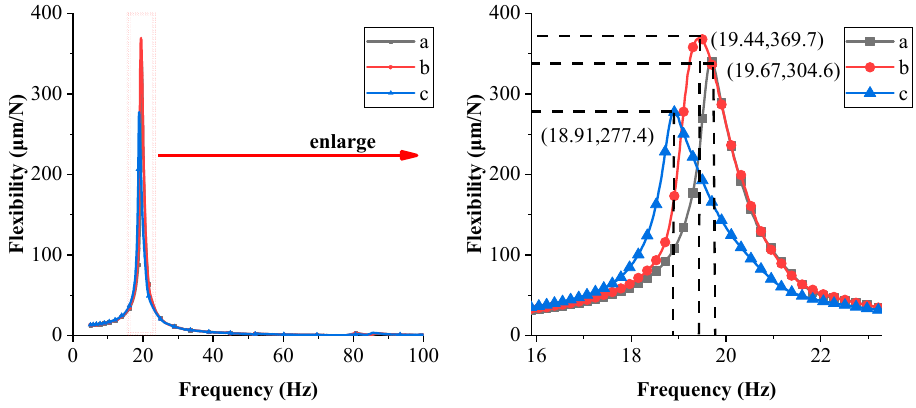
Figure 5. Frequency sweeping test results. Line a: Frequency sweeping curve for ≈ 5–100 Hz (exciting force = 1 N); Line b: Frequency sweeping curve for ≈ 100–5 Hz (exciting force = 1 N); Line c: Frequency sweeping curve for ≈ 5–100 Hz (exciting force = 3 N).